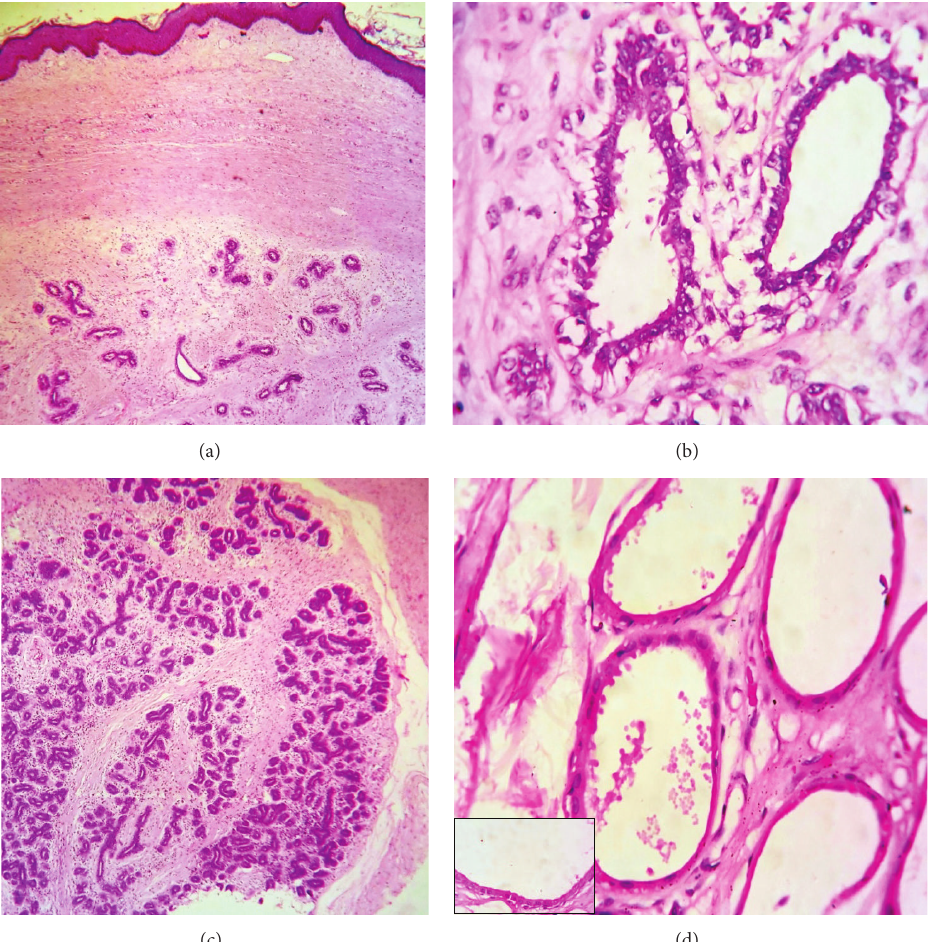
Figure 2: Microscopic appearance. (a) Anal skin with subepithelial tissue showing terminal duct lobular units. H&E 40x. (b) Ducts lined by bilayered epithelium. H&E 100x. (c) Areas of adenosis. H&E 40x. (d) Areas of cystic change. H&E 100x. (Inset, apocrine change with apical snouts, H&E